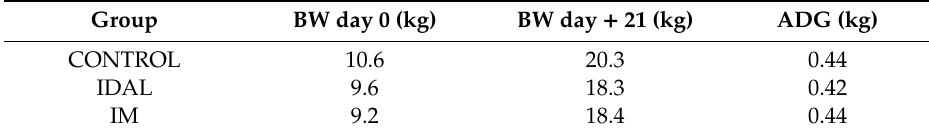
Table 9. Mean body weight the day of the vaccination (Day 0) and 21 days after the vaccination. Group BW day 0